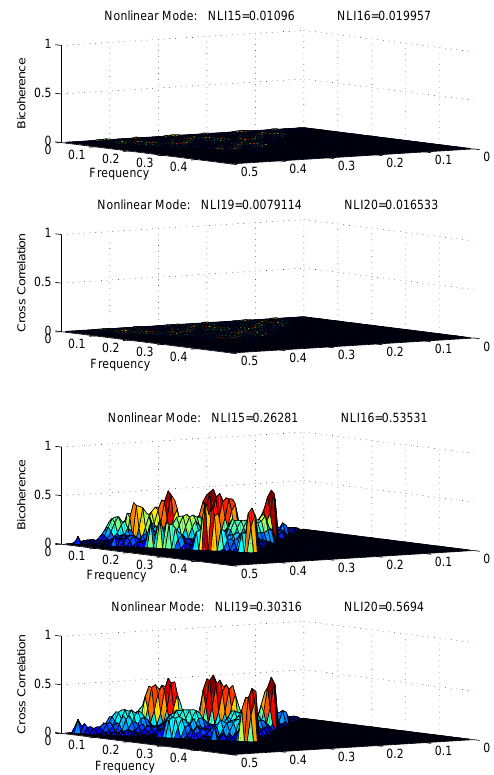
Figure 6: Nonlinearity measure based on indices NLI 15 , NLI 16 , NLI 19 , NLI 20 for Duffing system in Top. linear mode. Bottom. non- linear mode